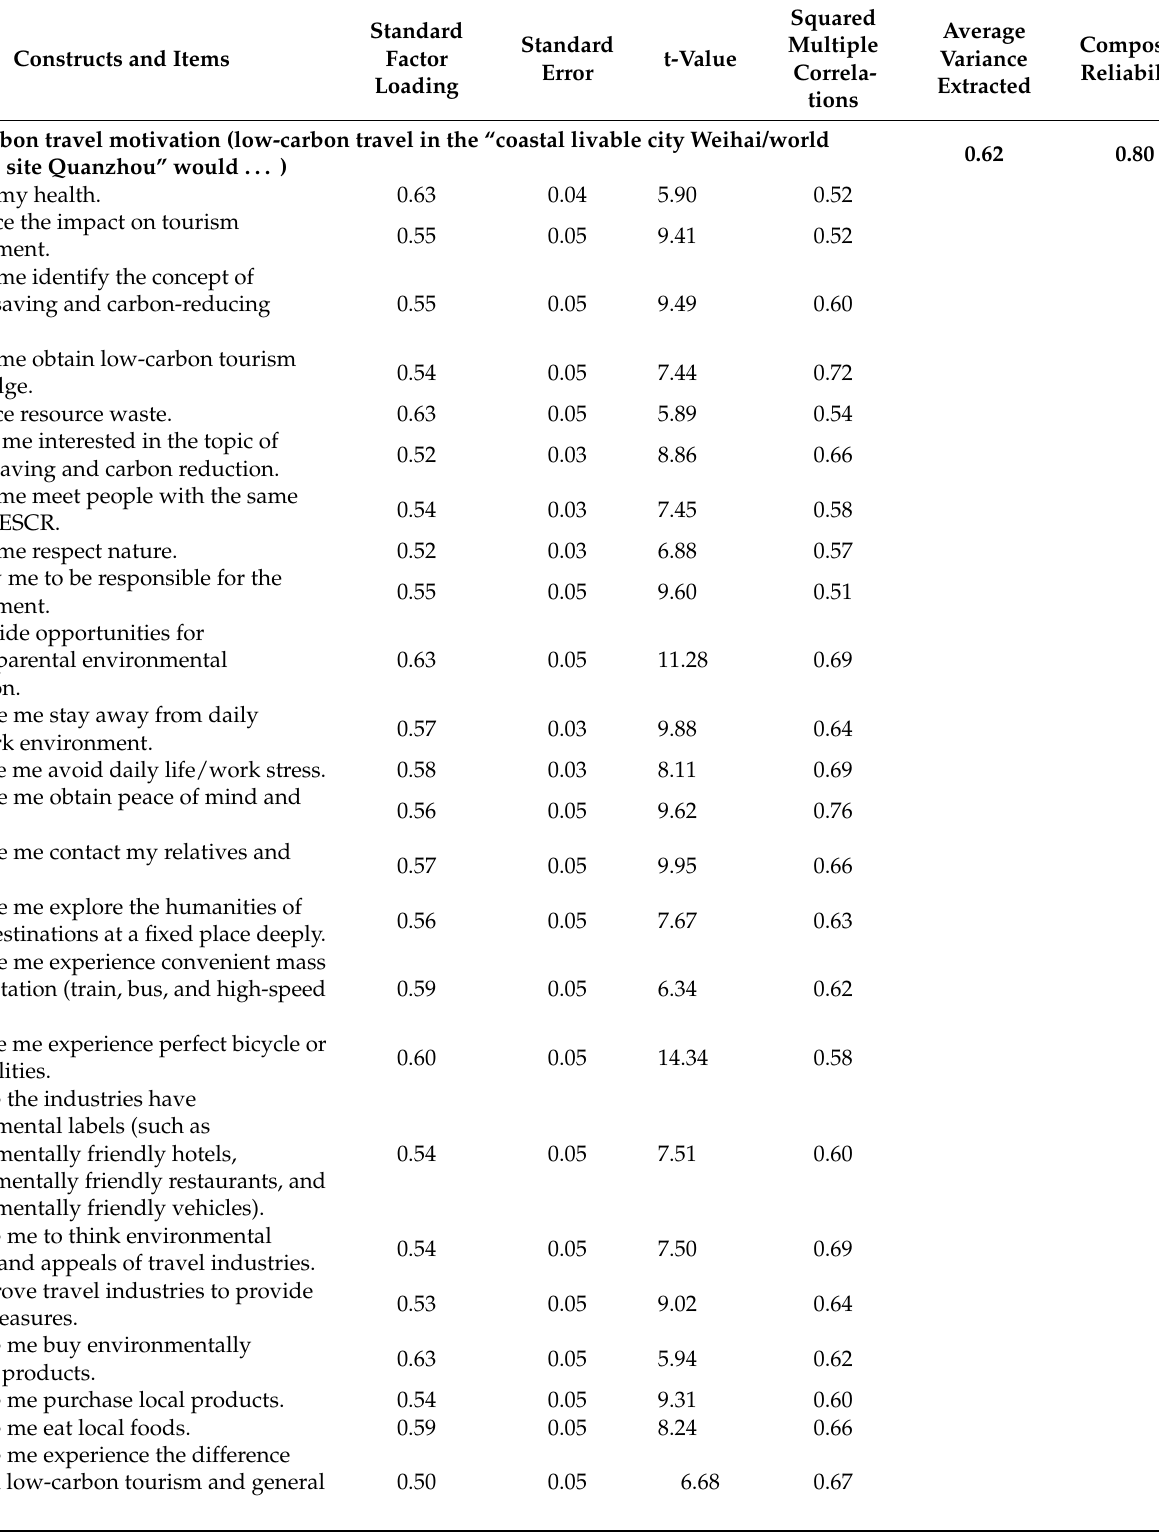
Table 1. Confirmatory factor analysis of measurement scale ( n =